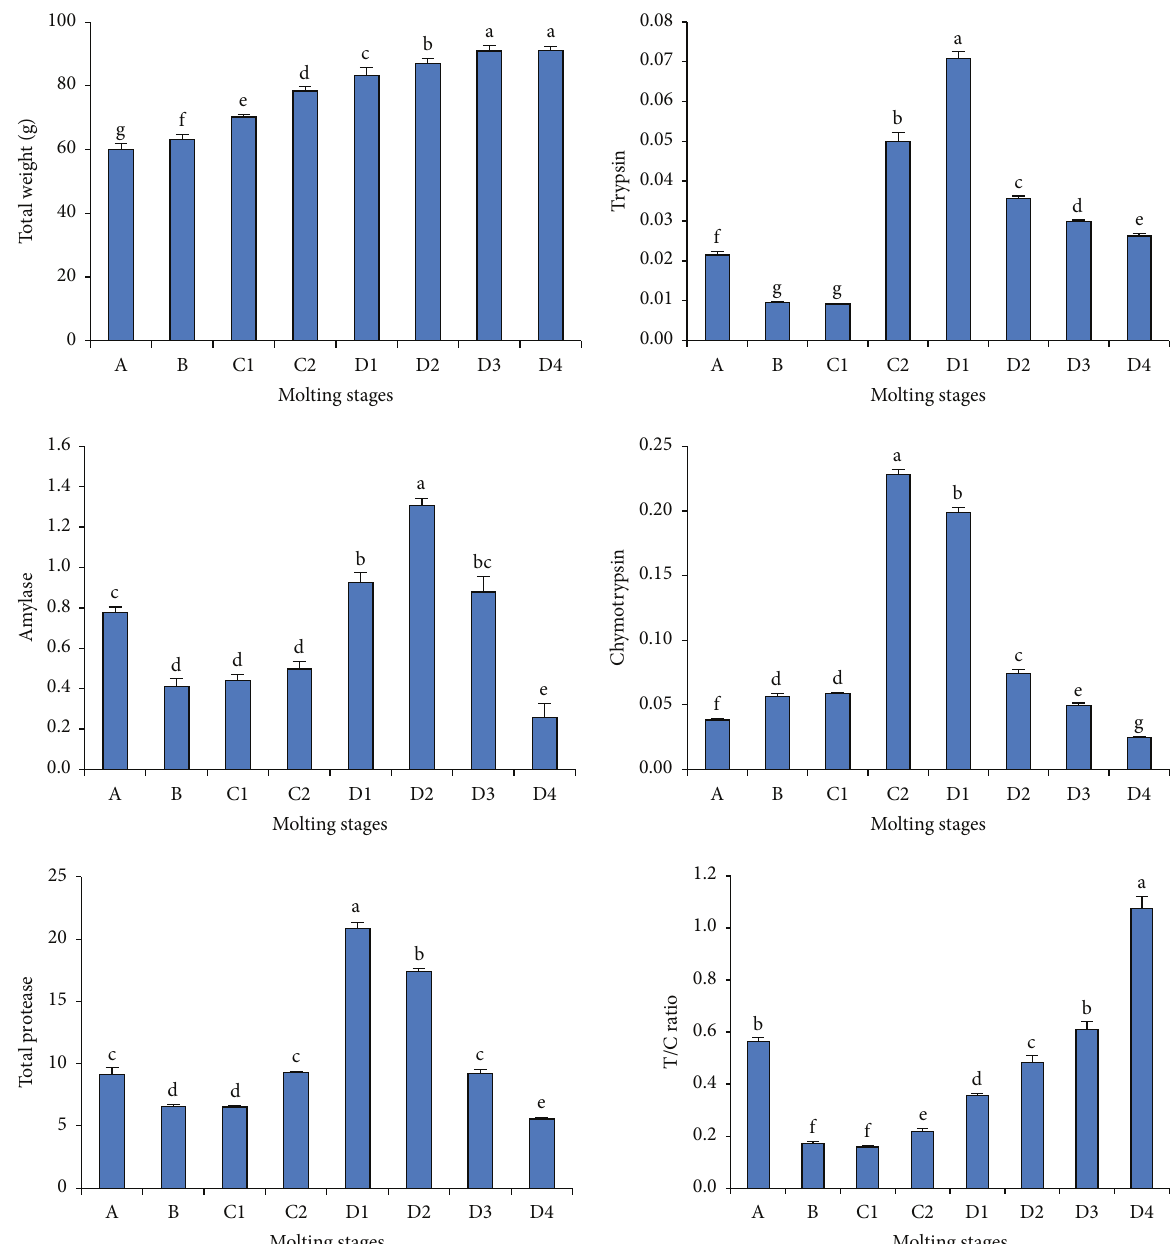
Figure 3: Total weight and specific activities of digestive enzymes, amylase ( 𝜇 mol maltose min −1 mg protein −1 ), total protease (Umg protein −1 ), trypsin and chymotrypsin ( 𝜇 mol p -nitroaniline min −1 mgprotein −1 ), and activity ratio of trypsin to chymotrypsin (T/C ratio) of adult P. pelagicus during a molting period; early postmolt (A), postmolt (B), intermolt (C1), late intermolt (C2), early premolt (D1), mid premolt (D2), late premolt (D3), and very late premolt (D4). Vertical bars indicate ± SEM ( 𝑛 = 3–5). The bars with different superscripts are significantly different ( 𝑃 < 0.05